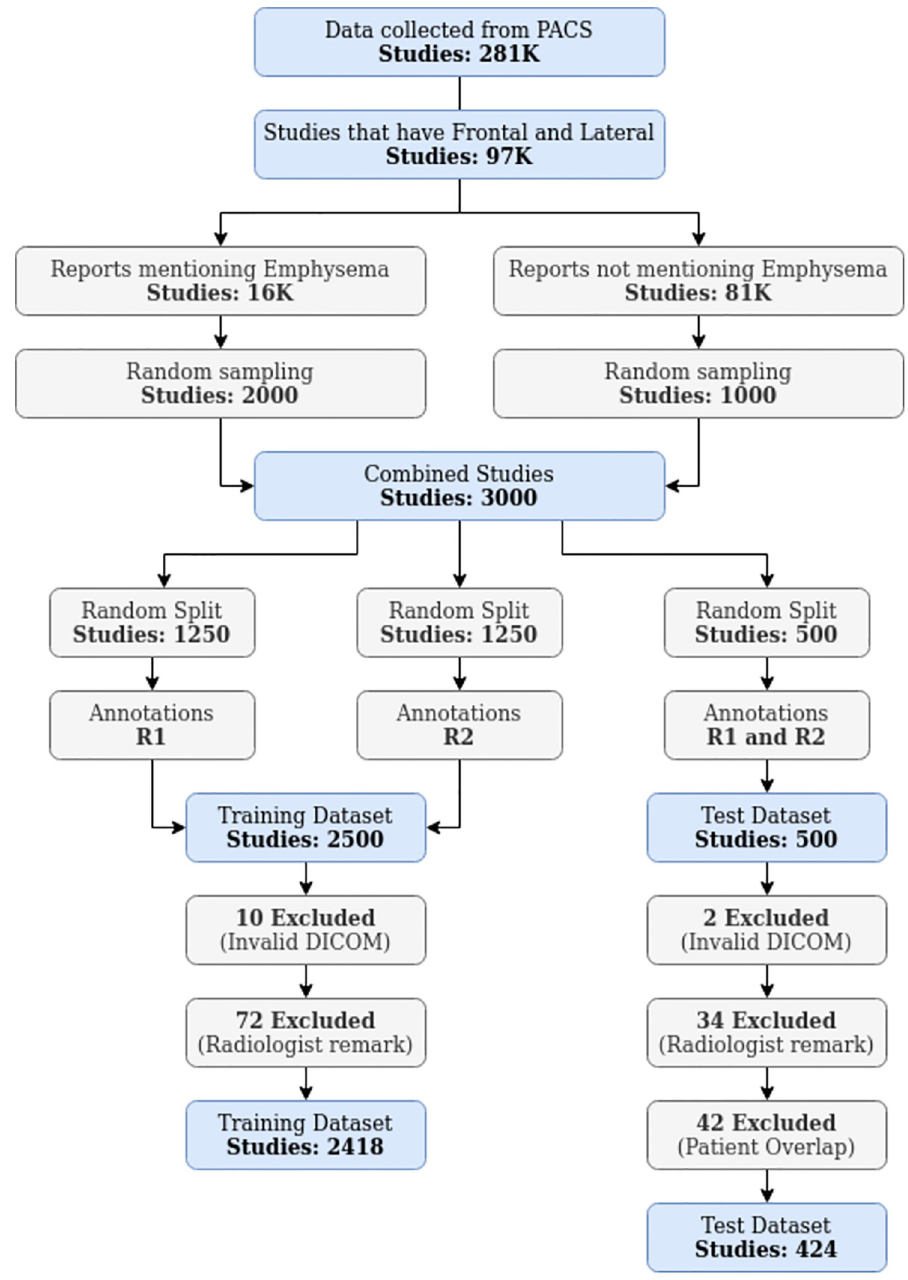
Fig 2. Data acquisition